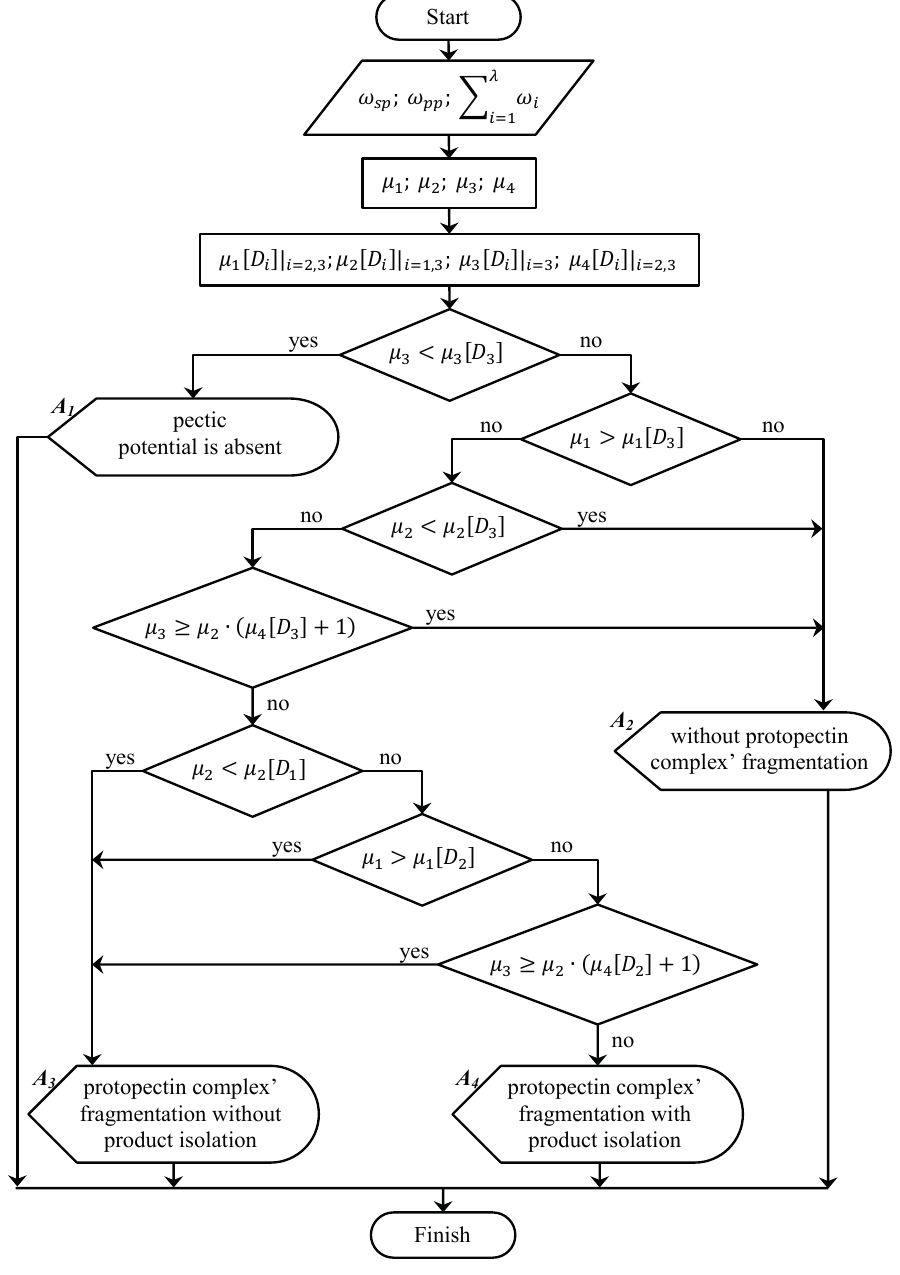
Figure 10 Algorithm for plant tissue classification according to protopectin fragmentation potential based on the geometric location in the zoned criterion